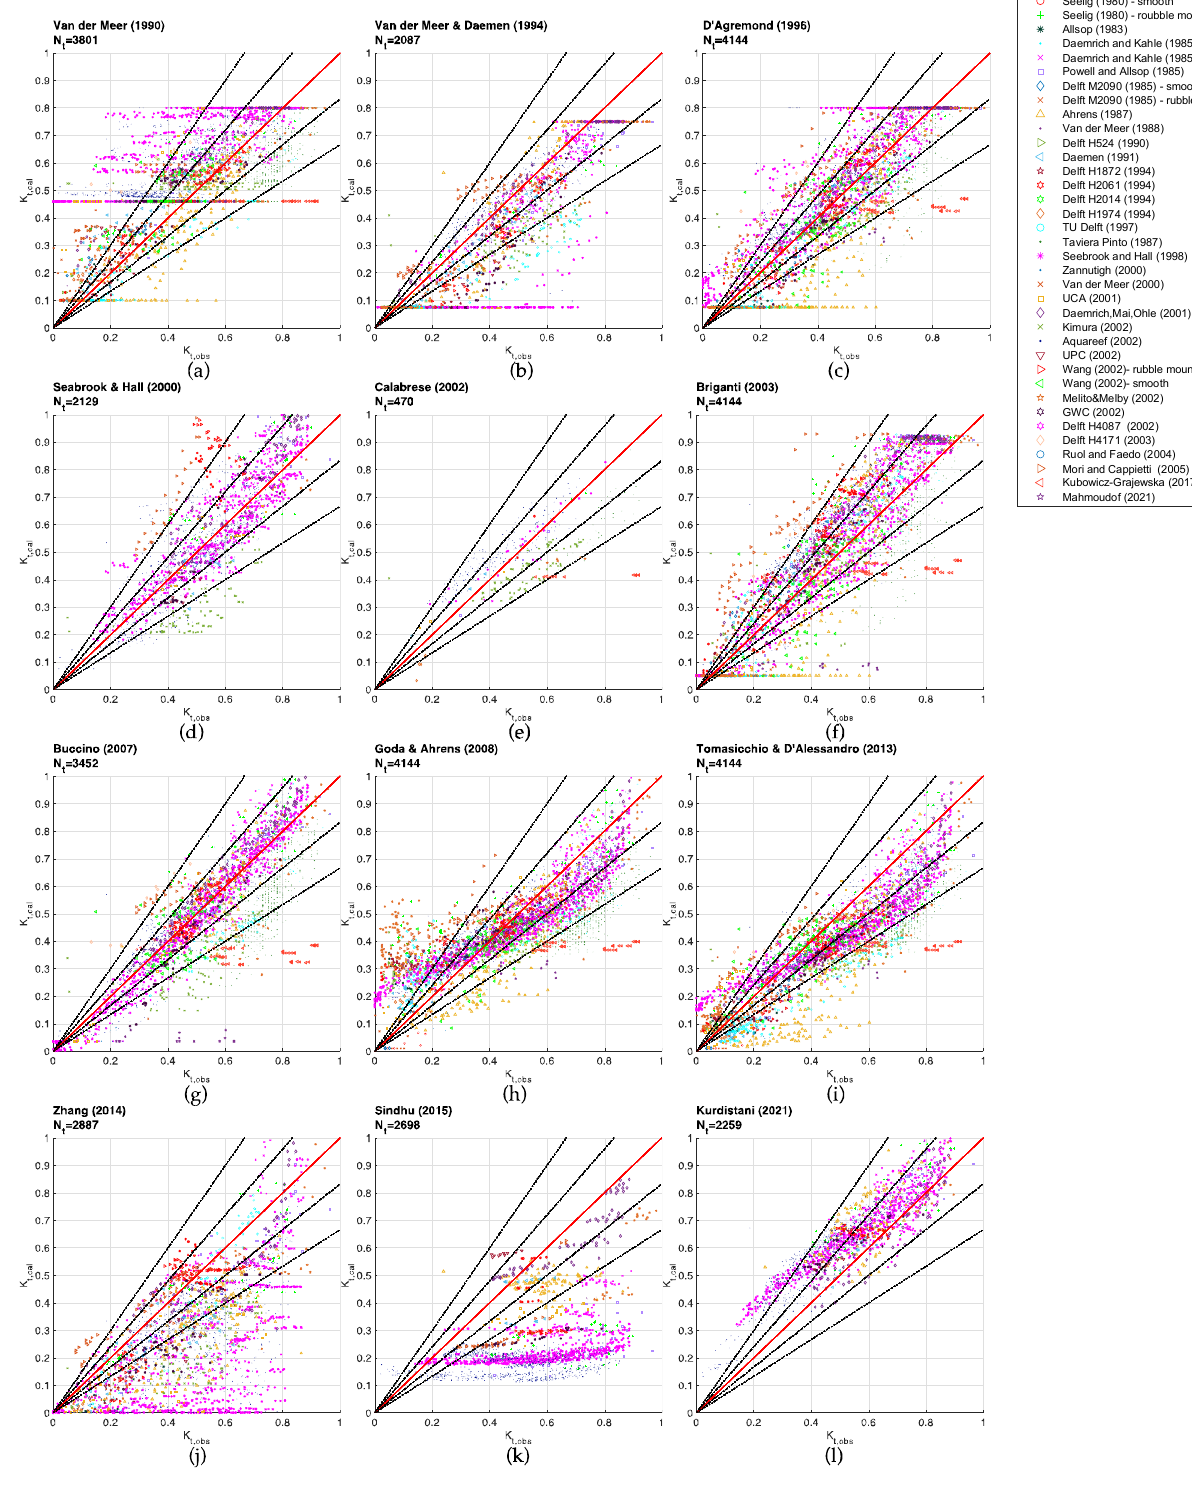
Figure 2. Comparison between Kt calculated and observed against the full database for ( a ) Van der Meer (1990) ( b ) Van der Meer and Daemen (1991) ( c ) D’Agremond et al. (1996) ( d ) Seabrook & Hall (1998) ( e ) Calabrese et al. (2002) ( f ) Briganti et al. (2003) ( g ) Buccino et al. (2007) ( h ) Goda & Ahrens (2008) ( i ) Tomasicchio & D’Alessandro (2013) ( j ) Zhang et al. (2014) ( k ) Sindhu et al. (2015) ( l ) Kurdistani et al. (2021). The diagonal red line represents the condition of perfect agreement where K t_obs = K t_calc . The dotted lines represent the confidence levels of ±20% and ±50%, respectively.